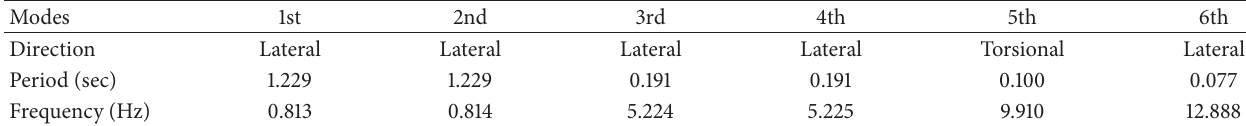
Table 2: The first six calculated natural periods and frequencies before seismic strengthening.